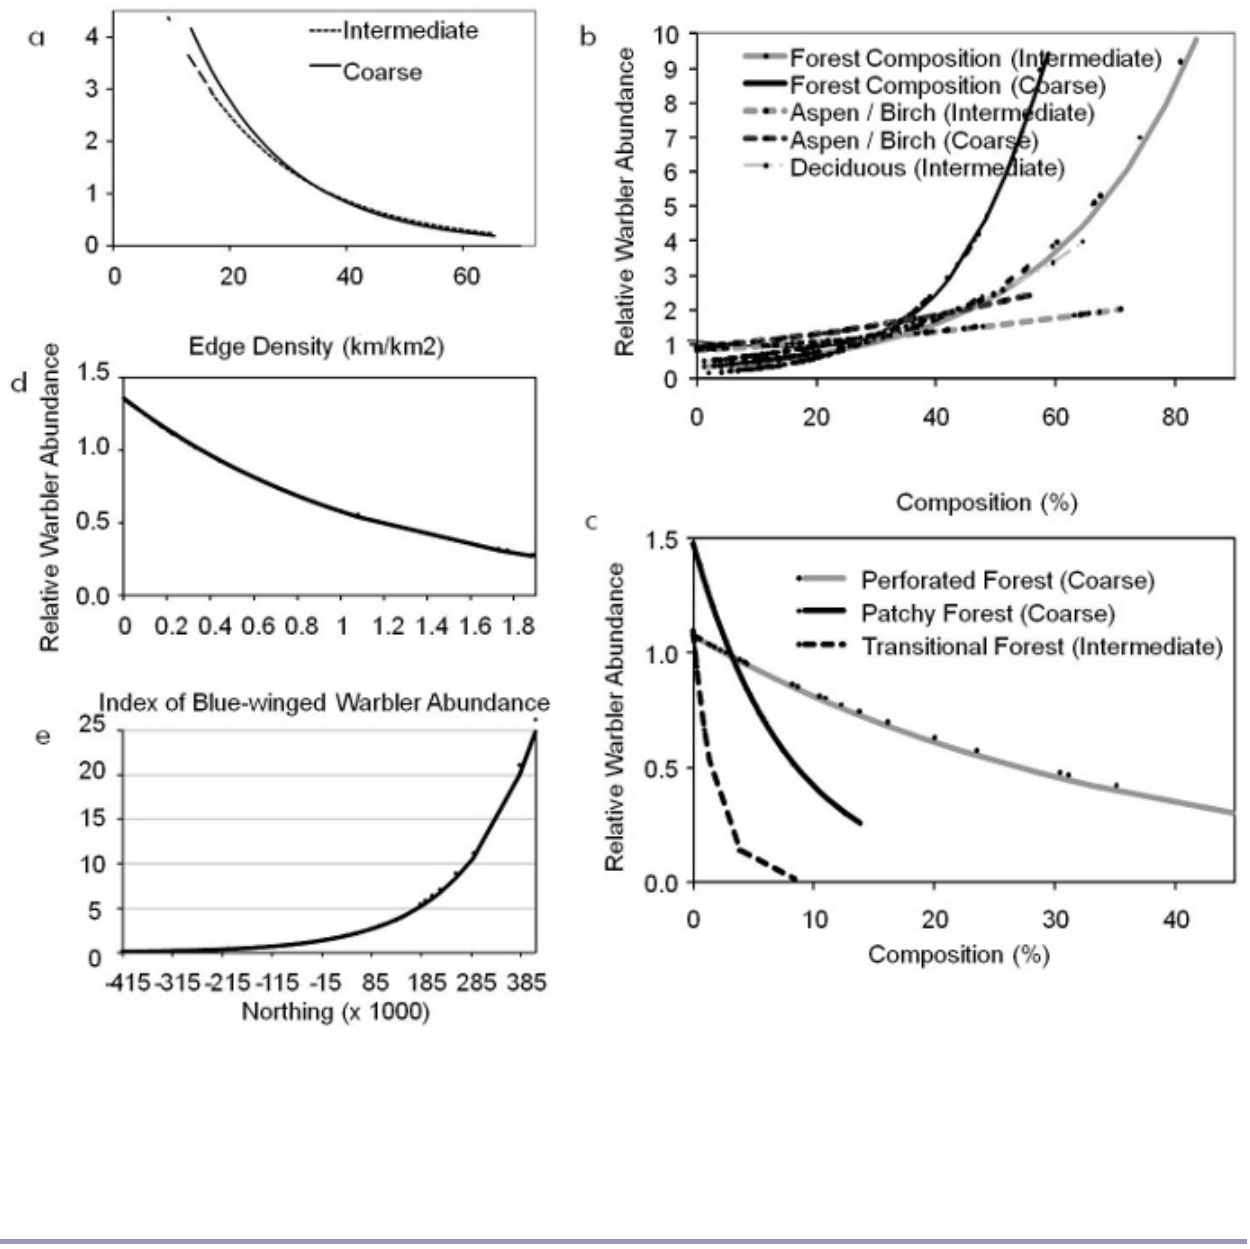
Fig. 2. Mean contribution of environmental covariates to the expected Golden-winged Warbler b x ( Vermivora chrysoptera ) count (y = e , where y is the expected count and x is the value of the standardized variable), as derived from an average model for the Prairie Hardwood Transition of the upper midwestern United States. Coarse refers to the variable at the 80,000 ha scale; intermediate refers to the variable at the 8000 ha scale. Note the differing